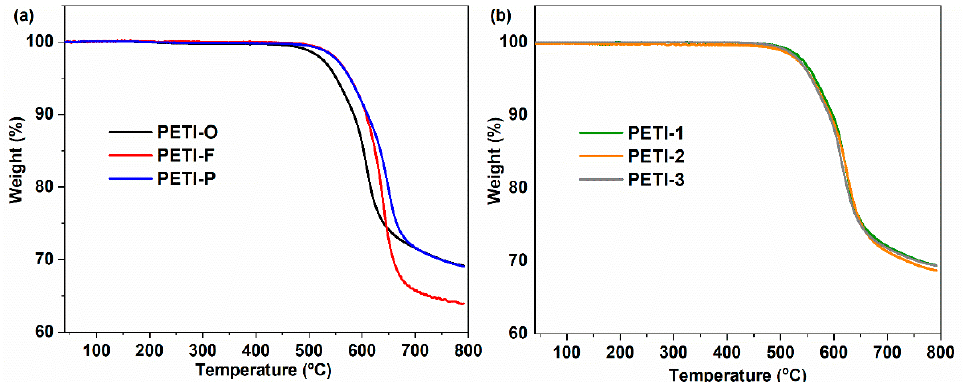
Figure 16. Thermogravimetric analysis (TGA) curves of cured resins in N2 atmosphere; ( a ) curves of cured PETI-O, PETI-F and PETI-P; ( b ) curves of cured PETI-1, PETI-2 and PETI-3